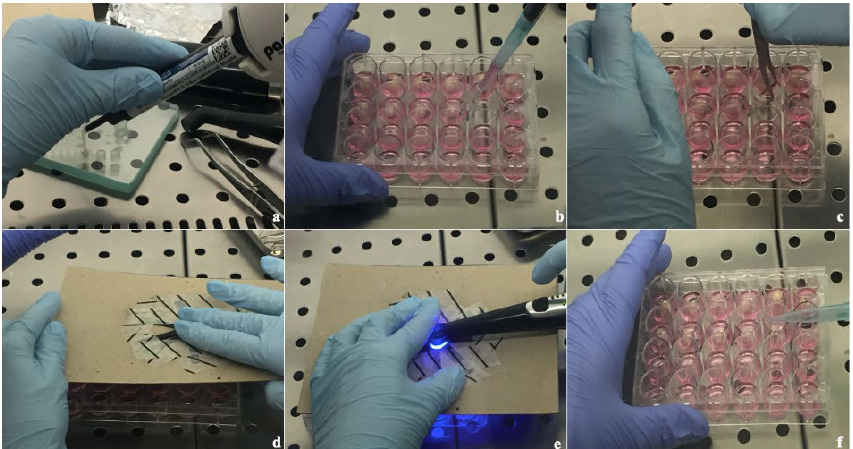
Figure 1. Application of experimental groups ( a ) Placing the material in the molds, ( b ) Removal of cells medium, ( c ) Placement of material on cells, ( d ) Placement of the barrier, ( e ) Polymerization of the material, and ( f ) Addition of cell mediums.